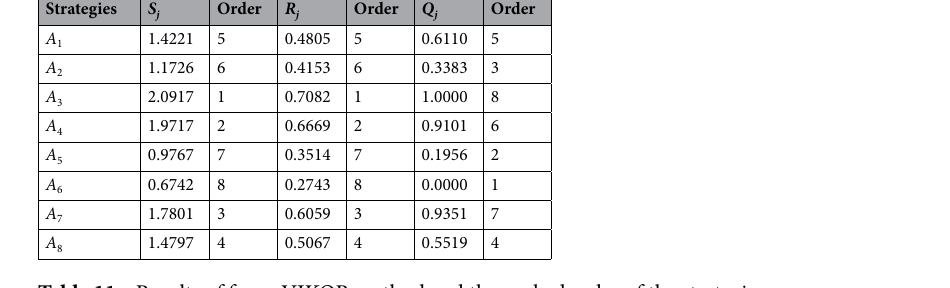
Table 11. Results of fuzzy VIKOR method and the ranked order of the